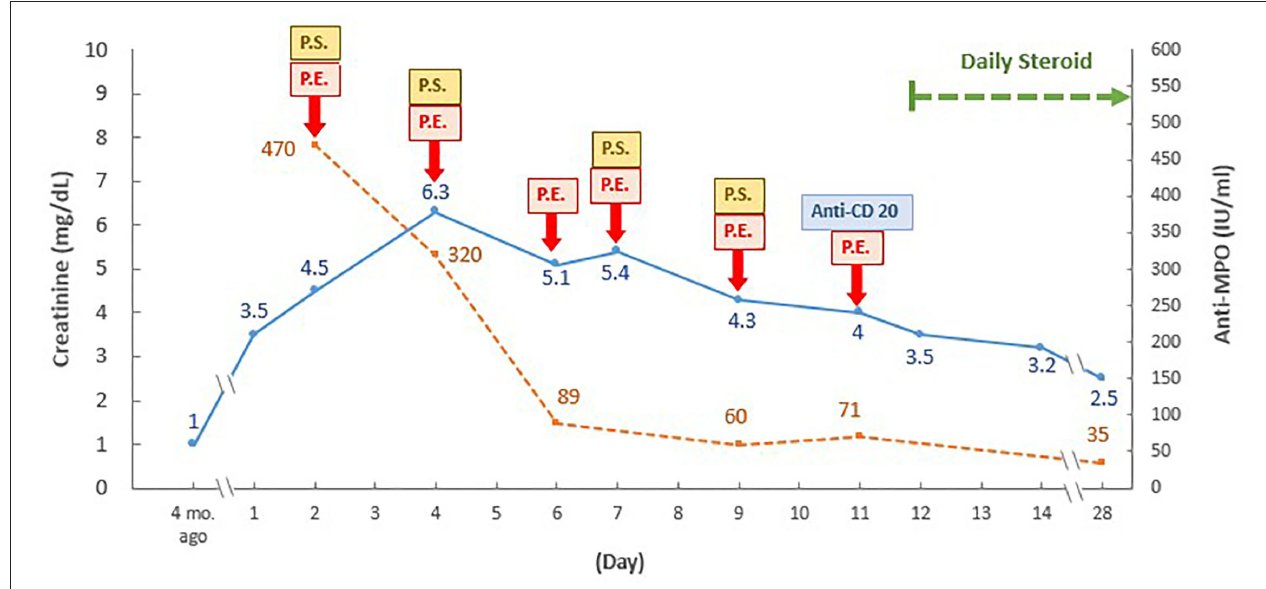
FIGURE 2 | Time and therapeutic course of anti-neutrophil cytoplasmic antibody-associated vasculitis with rapidly progressive glomerulonephritis following COVID-19 vaccination. PE, plasma exchange; P.S., pulse steroid; ANCA, anti-neutrophil cytoplasmic antibody; Anti-MPO, anti-myeloperoxidase-O, mo., month. Daily pulse steroid dosage: intravenous methylprednisolone 1,000mg daily in the first course, then 500mg daily in the following three